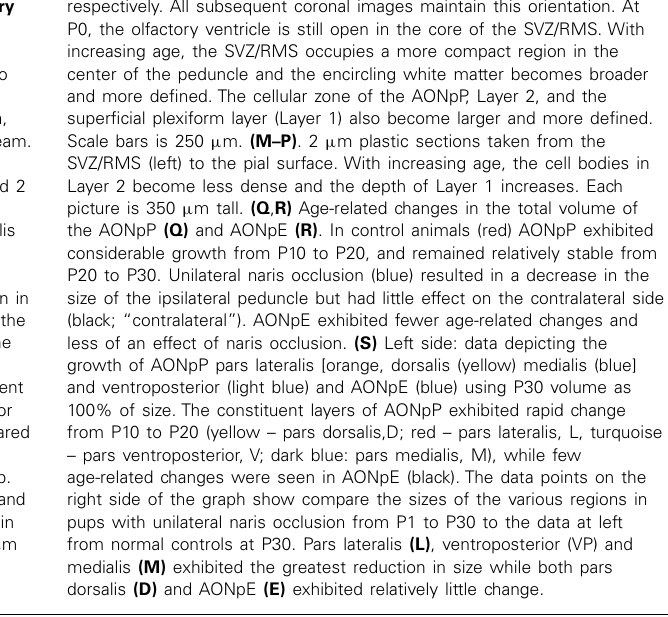
FIGURE 1 | Nissl-stained sections of the developing mouse olfactory peduncle. (A) Diagram depicting the OP (red), and the two planes of section used in the subsequent panels: horizontal (blue) and coronal (green). (B) Diagram of regions seen in horizontal sections: rostral is to left and medial to top. OB, olfactory bulb; OT, olfactory tubercle; PC, piriform cortex; ALAC, anterior limb of the anterior commissure. Green, AONpP; orange, AONpE; red, subventricular zone/rostral migratory stream. (C) Diagram of regions seen in coronal sections through the caudal peduncle: Dorsal to top, lateral to right. 1, 2 = Layers 1 (plexiform) and 2 (cellular) regions of the AONpP. The region is also divisible into pars lateralis (l, under the LOT, shaded green), pars dorsalis (d), pars medialis (m), and pars ventroposterior (vp). Red, subventricular zone/rostral migratory stream; Yellow, ALAC. (D) Diagram depicting approximate location of the 350 μ m-wide standardized region in the lateral OP seen in panels M, N, O, P, and in subsequent figures. (E–L) From left to right the columns depict tissue from newborn (P0), P10, P20, and P30 pups. The two rows contain developmental sequences in horizontal (E–H) and coronal (I–L) planes. The general organization of the peduncle is apparent at birth (E) . Note the obvious transition from the AONpP to the anterior piriform cortex (red arrow) and olfactory tubercle (green arrow). Compared to the older ages the darkly staining SVZ/RMS occupies a much great proportion of the center of the peduncle and core of the olfactory bulb. The ALAC, seen as a large white matter tract lateral to the RMS in F and G, is not as well developed at P0. Scale bar is 500 μ m [ (B–D) scaled in (D)] . (I–L) Coronal sections taken from the caudal peduncle. (E,F) : 2 μ m plastic sections. (G,H) : 60 μ m vibratome sections. The caudal-most remnant of the OB and the LOT are at the left and right borders,